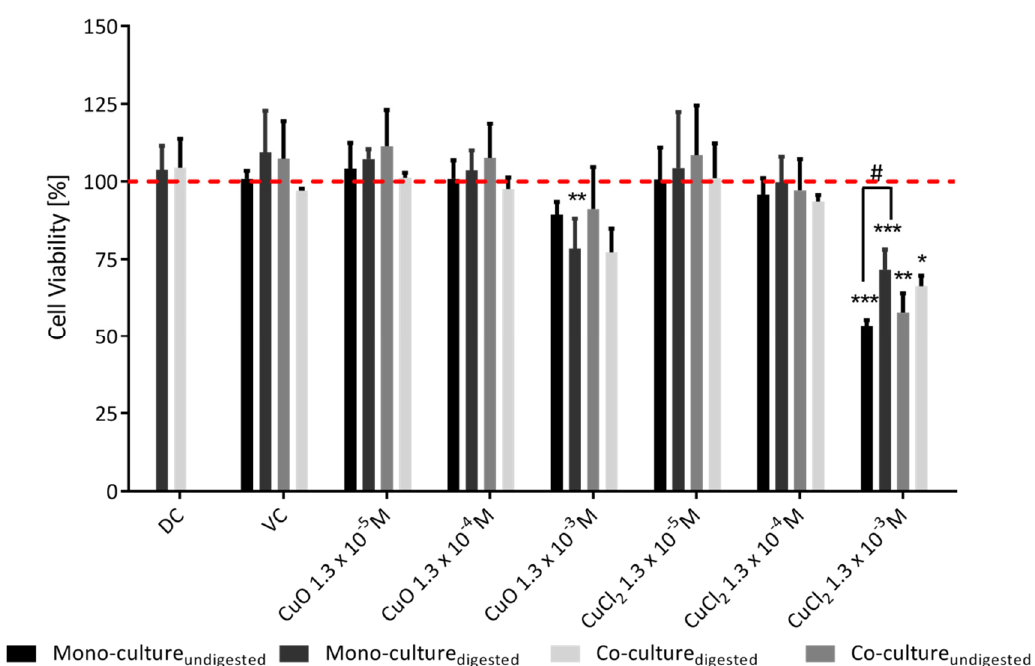
Figure 5. The effect of the digestion process on the cytotoxicity of copper oxide nanoparticles was determined via propidium iodide staining and flow cytometry. The cells of the Caco-2 mono-culture and the Caco-2/HT29-MTX co-culture were incubated with 10% digestive juice (DC), 0,05% BSA solution and CuO-NP/CuCl 2 for 24 h. The mean vitality values were normalized to those of the negative control (NC), represented by the red line. The statistical differences between the samples and the NC are marked as * p < 0.05, ** p < 0.01 and *** p < 0.001, and the statistical difference between the digested/undigested samples is marked as # p < 0.05. The error bars represent the standard deviation of three independent measurements.